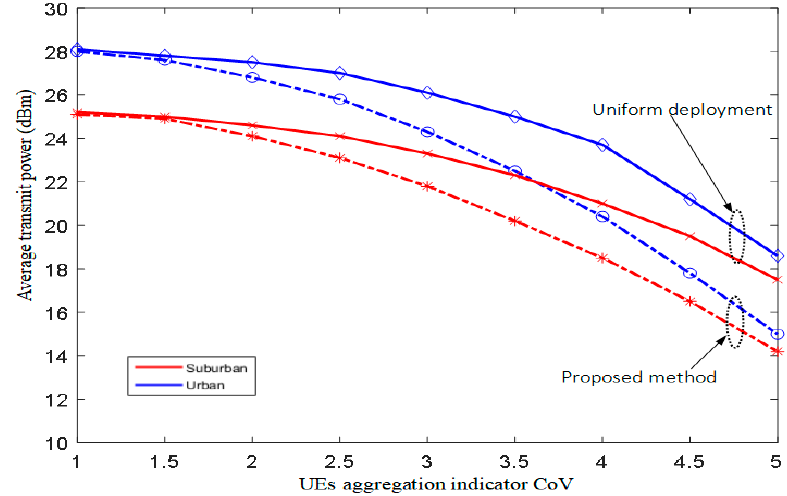
Figure 7. Average transmit power vs. CoV.